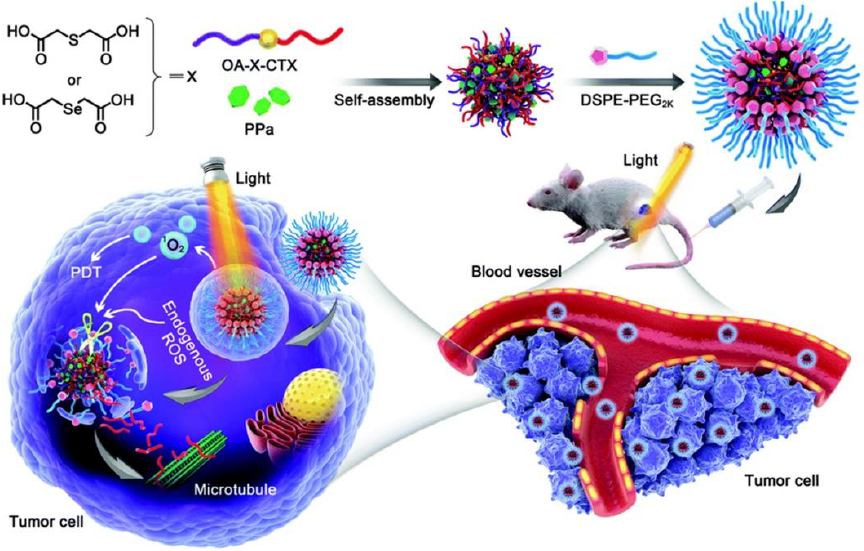
Figure 6. Schematic illustration of self-assembly of OA-X-PTX nanoparticle loaded with PPa and its cascade amplification release process. Reproduced from [44] with permission, copyright 2018, Royal Society of Chemistry.